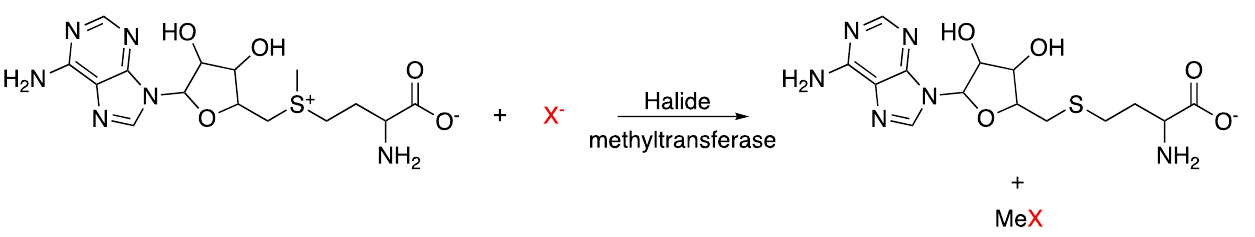
Figure 23. Example of a halide methyltransferase catalyzed reaction.